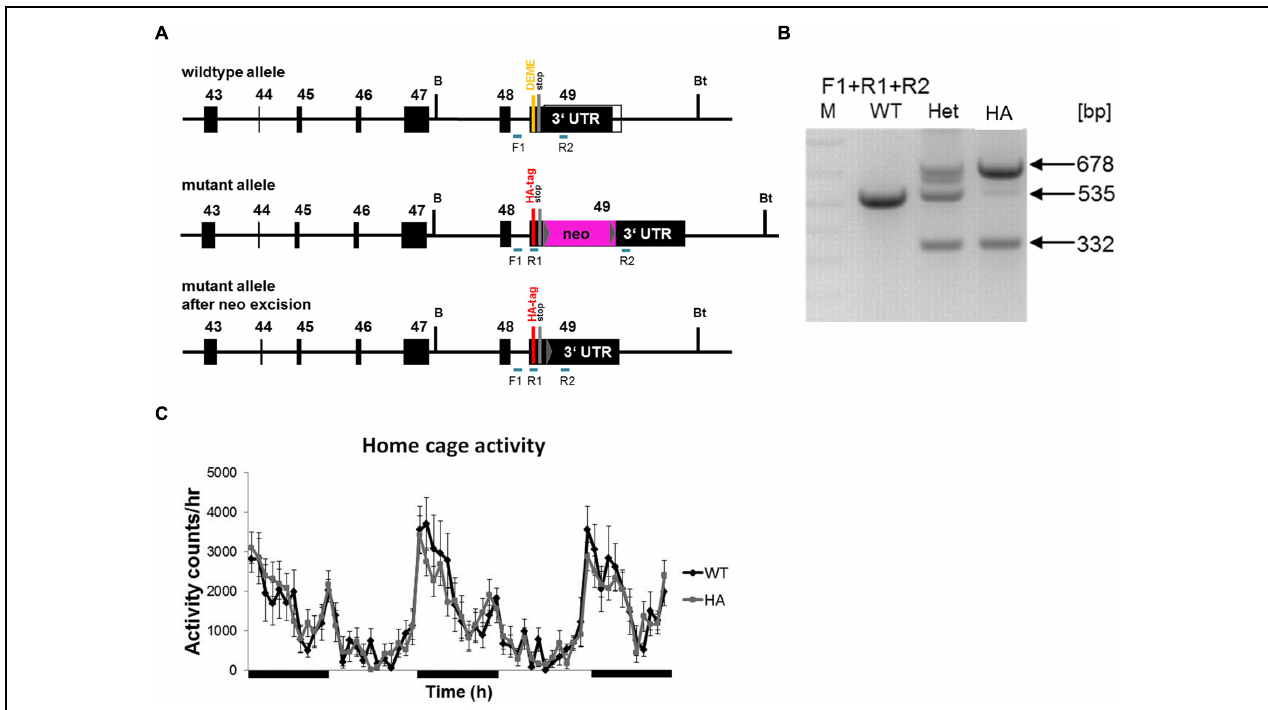
FIGURE 2 | Gene targeting strategy to generate Cav1.3DCRD HA / HA mice. (A) PCR primer positions for genotyping (see Materials and Methods) are indicated. WT allele, mutated allele and mutated allele after neo excision are shown. DEME, single amino acid letter code for negatively charged DCRD sequence replaced by HA-tag as indicated. F1, R1, R2 indicate forward and reverse primers used for genotyping.